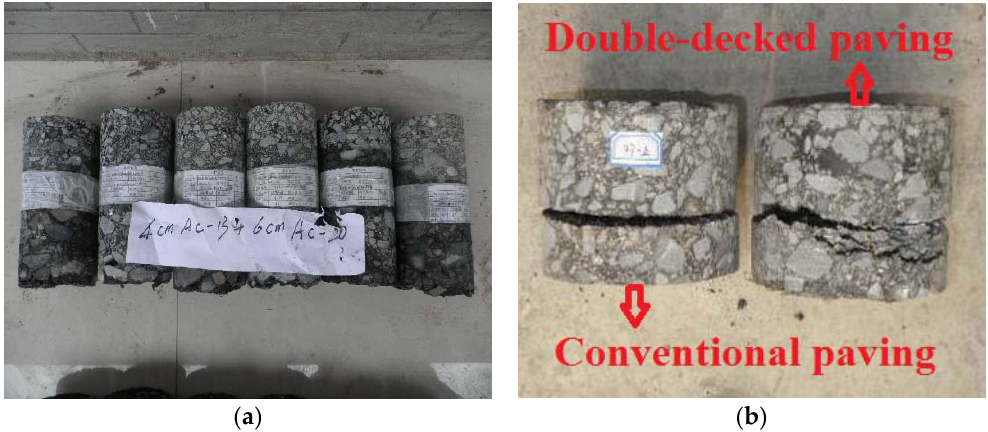
Figure 8. Specimens collected from the trial road constructed by conventional and double-decked